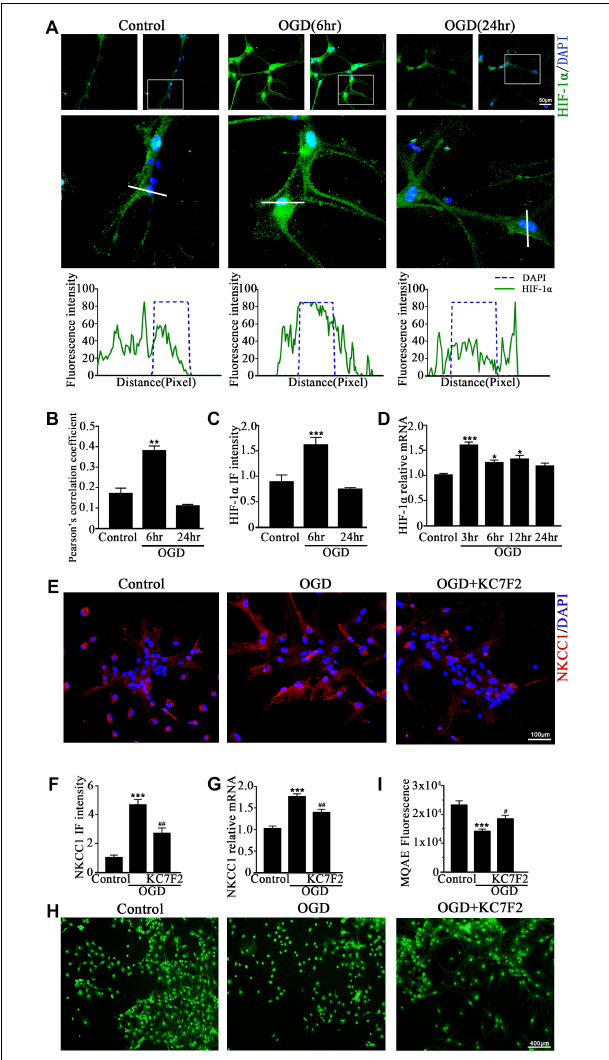
FIGURE 2 | HIF-1 α mediates NKCC1 expression. ( A , top) Confocal images showing co-localization of HIF-1 α and DAPI in neurons. ( A , middle) Enlarged views of indicated co-localization between HIF-1 α with DAPI. ( A , bottom) Side overlap of two peaks indicated partial co-localization. (B) Pearson’s correlation coefficient is shown in the graph from the analysis of independent experiments. (C) The intensity of HIF-1 α fluorescence was determined in 10 fields/well and divided by the number of cells counterstained with DAPI. (D) HIF-1 α mRNA expression level at 3, 6, 12, and 24 h after OGD. (E) Confocal image demonstrating NKCC1 expression in neurons after treatment with KC7F2 (10 mM). (F) The intensity of NKCC1 was determined in 10 fields/well and divided by the number of cells counterstained with DAPI. (G) NKCC1 mRNA level in neurons after treatment with KC7F2. (H,I) Fluorescence imaging of Cl − via MQAE staining in neurons. The green fluorescence indicates the intensity of MQAE. The values represent the mean ± SEM. ∗ p < 0.05, ∗∗ p < 0.01, ∗∗∗ p < 0.001 versus control (Tukey’s test after one-way ANOVA). # p < 0.05, ## p < 0.01 versus OGD (Tukey’s test after one-way ANOVA).